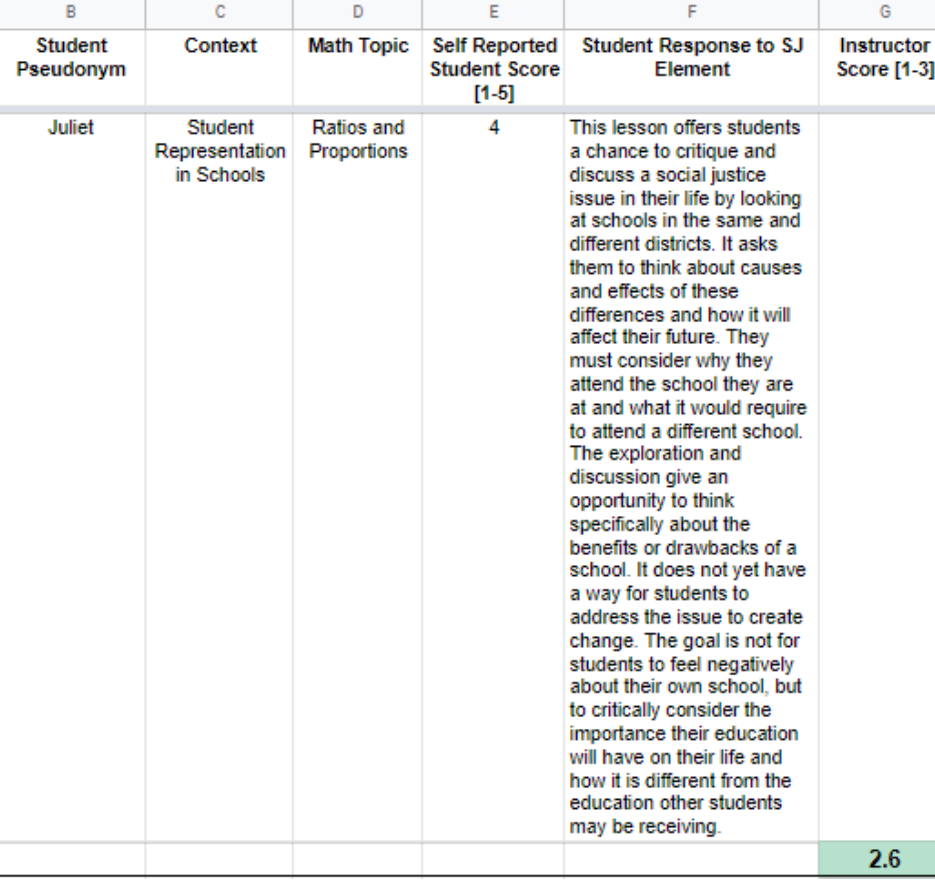
Figure A1. Social justice element analysis for Juliet.